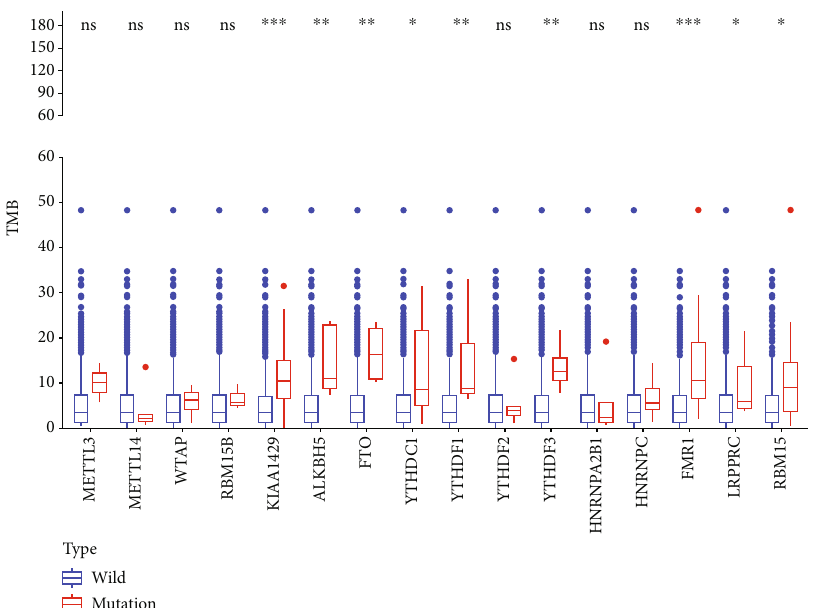
Figure 4: Di ff erences in TMB levels of 16 M6A-related genes between mutant groups and wild groups. Blue represents wild groups, red represents mutant groups, ∗ represents P < 0 : 05 , ∗∗ represents P < 0 : 01 , and ∗∗∗ represents P < 0 : 001 .